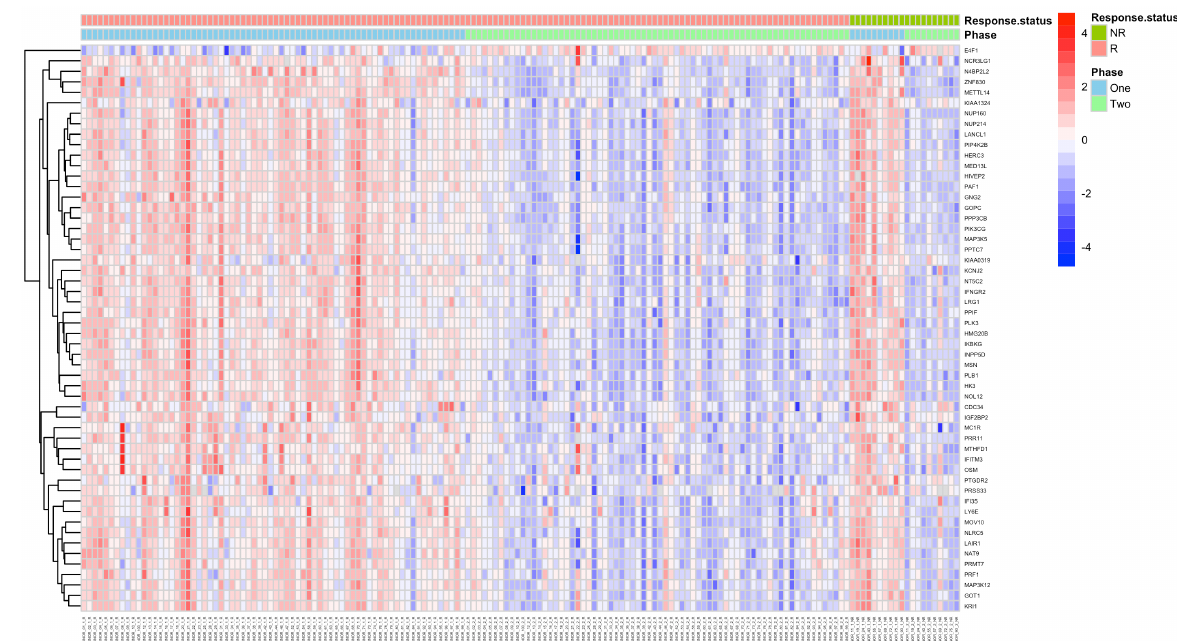
Figure 1. Drastic downregulation of gene expression observed with vitamin D3 supplementation. Normalized gene expression heatmap with unsupervised hierarchical clustering of significantly differentially expressed genes (n = 54) between supplementation periods and response group to supplementation. Each row represents a gene, and the columns represent the 80 study participants from the two supplementation phases/periods (total 160